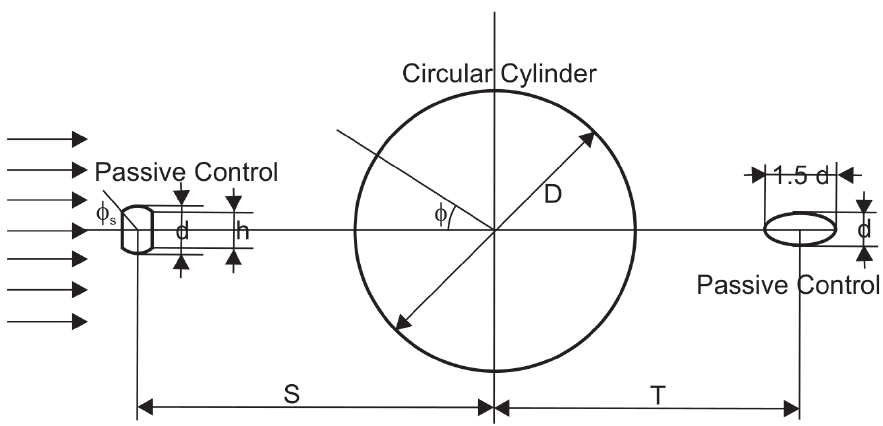
Figure 3. Schematic of two passive controls and a circular cylinder.